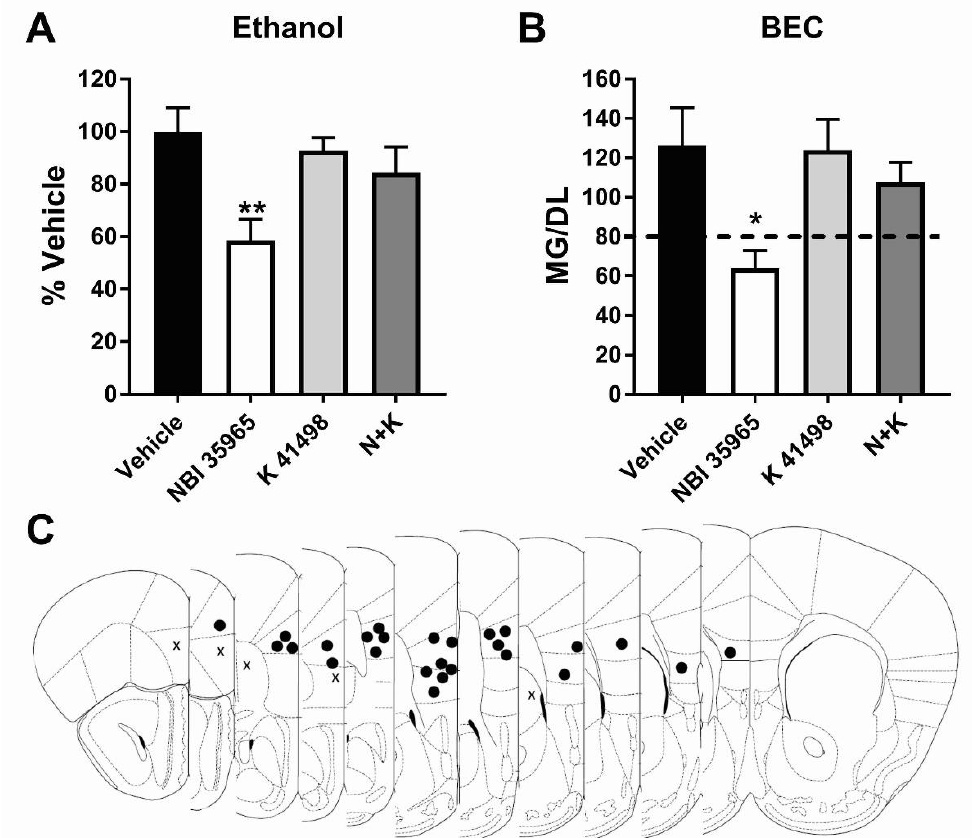
Figure 3. Co-administration of a CRF2R antagonist attenuates CRF1R antagonist blunting of binge ethanol intake. ( A ) A CRF1R antagonist alone, but not a CRF2R antagonist or CRF1R + CRF2R antagonist, reduced binge ethanol consumption and ( B ) final blood ethanol concentration compared to vehicle. ( C ) Cannula placement checks ( • = hit N = 26, X = miss N = 5). * = One-way ANOVA Dunnett’s posthoc test p < 0.05; ** = One-way ANOVA Dunnett’s posthoc test p < 0.01.